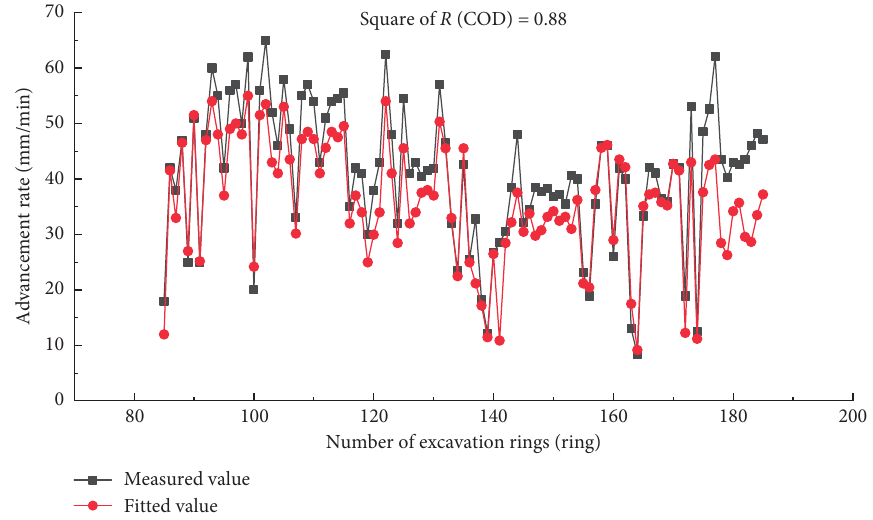
Figure 8: Comparisons between model calculation and measured data. Table 5: Comparison of measured and predicted lines.